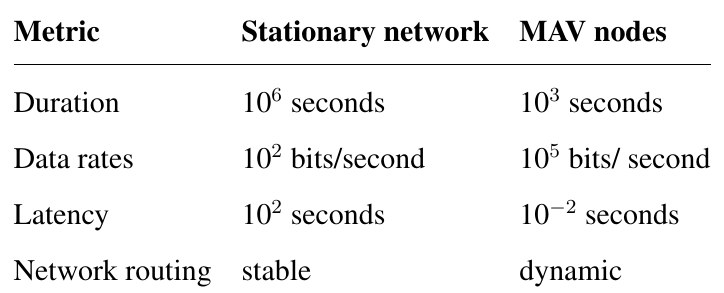
Table 1. Differences in design parameters between stationary and mobile nodes in a hybrid sensor